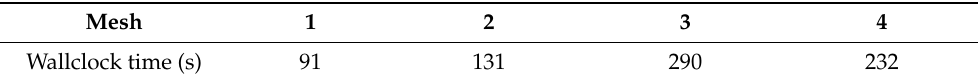
Figure 9. Crack trajectories recovered from past research ( a , b ) and comparison with mesh 4 results; ( c ) evolution of crack trajectories in the current simulation using different refinement levels. Table 9. Performance information in terms of wallclock time for the different refinement levels using the fib model code 2010 [32] softening